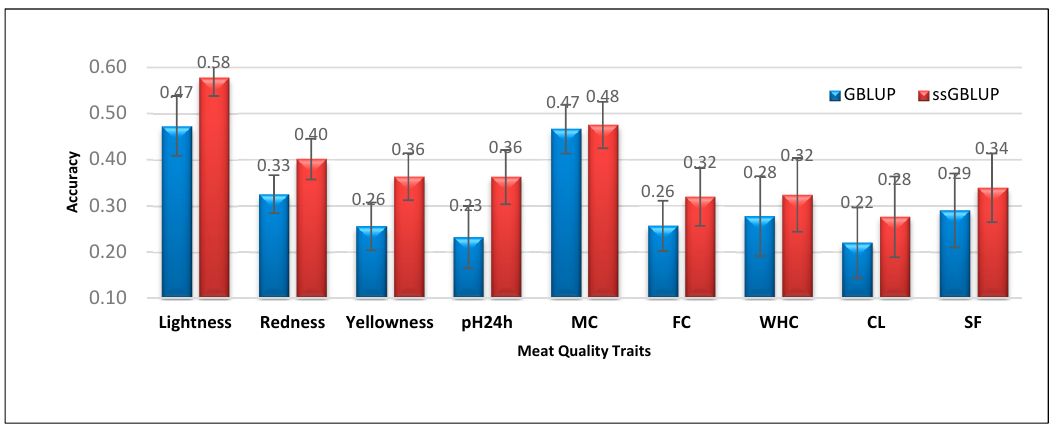
Figure 1. Prediction accuracies and standard errors obtained using genomic best linear unbiased prediction (GBLUP) and single-step GBLUP (ssGBLUP) for meat quality traits. pH24h—pH at 24 h post-mortem; MC—moisture content; FC—fat content; WHC—water-holding capacity; CL—cooking loss; SF—shear force.